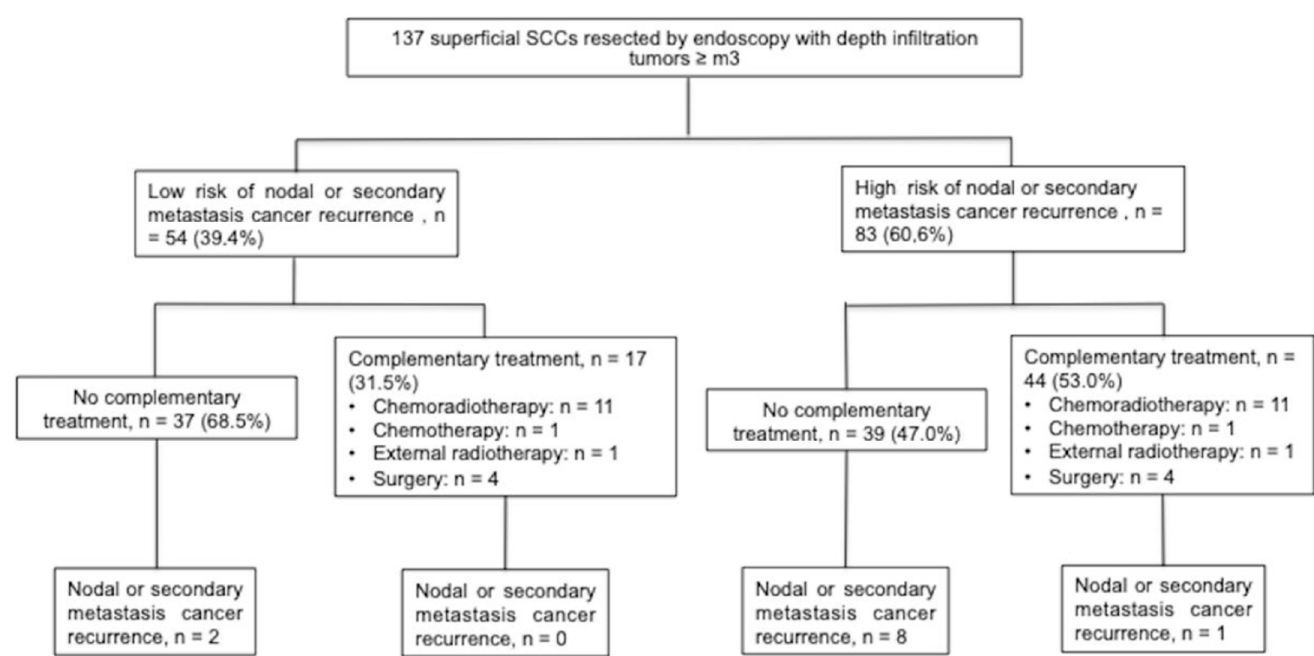
Figure 3. Flow chart of tumors after endoscopic resection according to the risk of nodal or metastatic recurrence with and without adjuvant chemoradiotherapy and/or surgery. SCC, squamous cell carcinoma; m3, invasive carcinoma limited to the muscularis mucosae; sm, invasive carcinoma limited to the submucosa. Low risk of nodal and/or distal metastasis was defined as an infiltration depth of ≤ Sm1, with no lymphovascular invasion and well differentiated. A high risk of nodal and/or distal metastasis was defined as an infiltration depth of ≥ Sm2, positive lymphovascular invasion, or mildly and poorly differentiated.